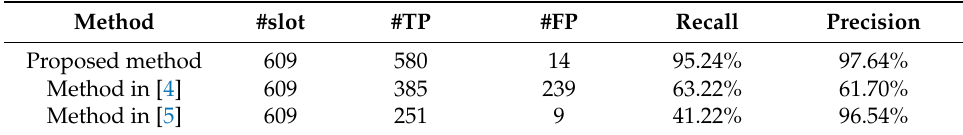
Table 5. Performance of all three